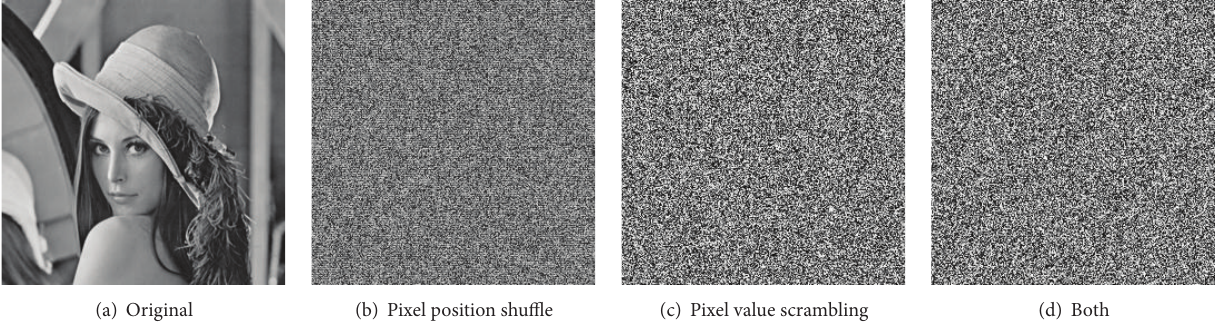
Figure 5: Encryption results with pixel value scrambling and position